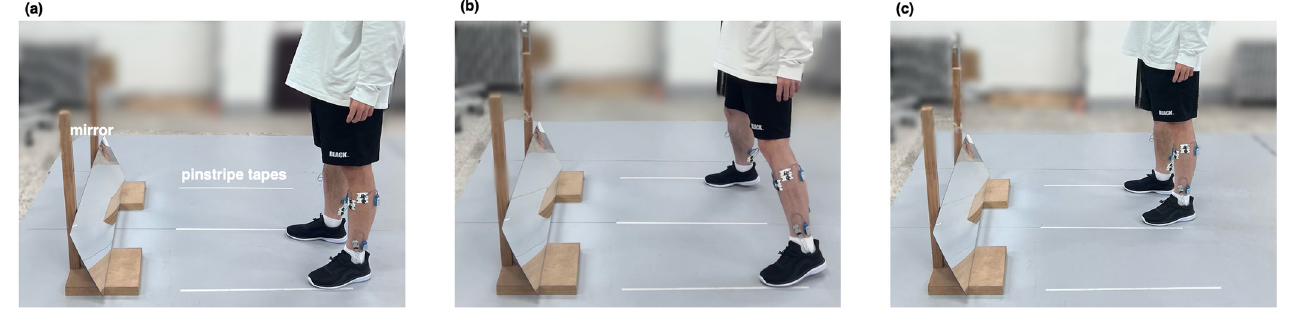
Fig 1. Experimental setup and procedure for the step-aside